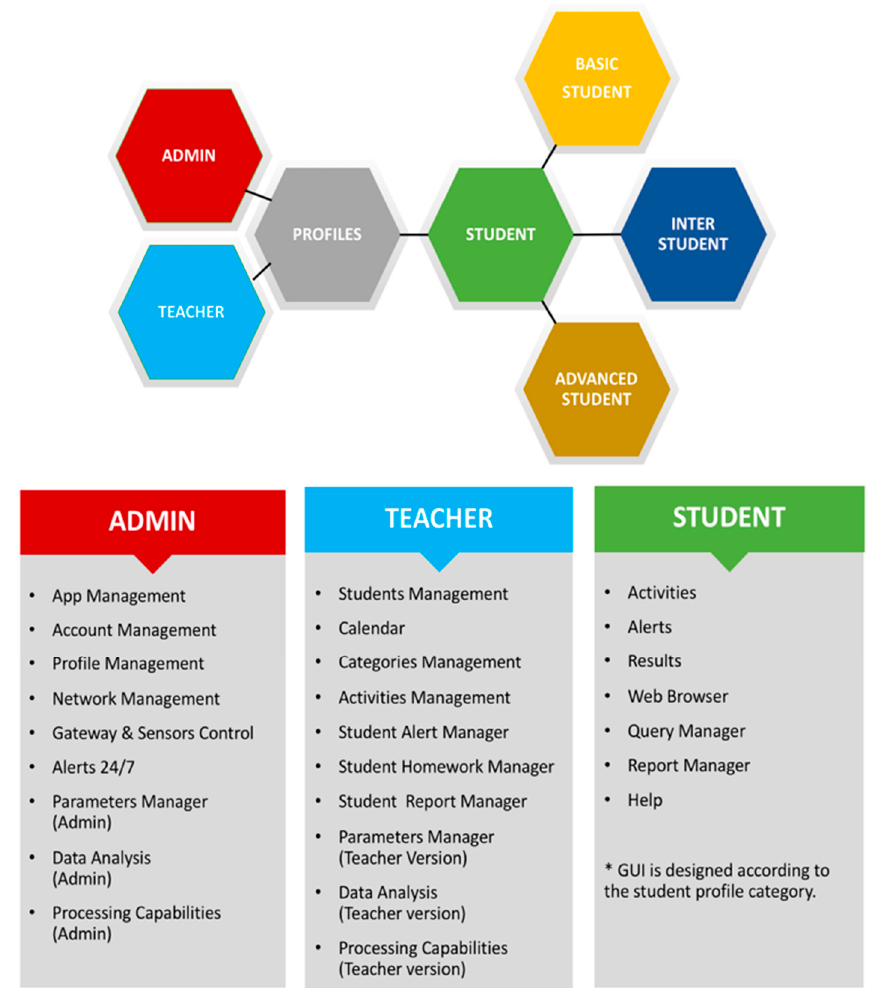
Figure 12. MySchoolGardenApp Profiles and General Tasks.